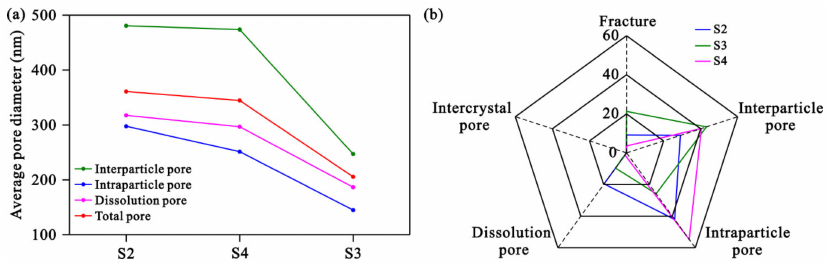
Figure 7. Pore size and type distributions in felsic-rich shales: ( a ) Average pore diameter; ( b ) Pore type